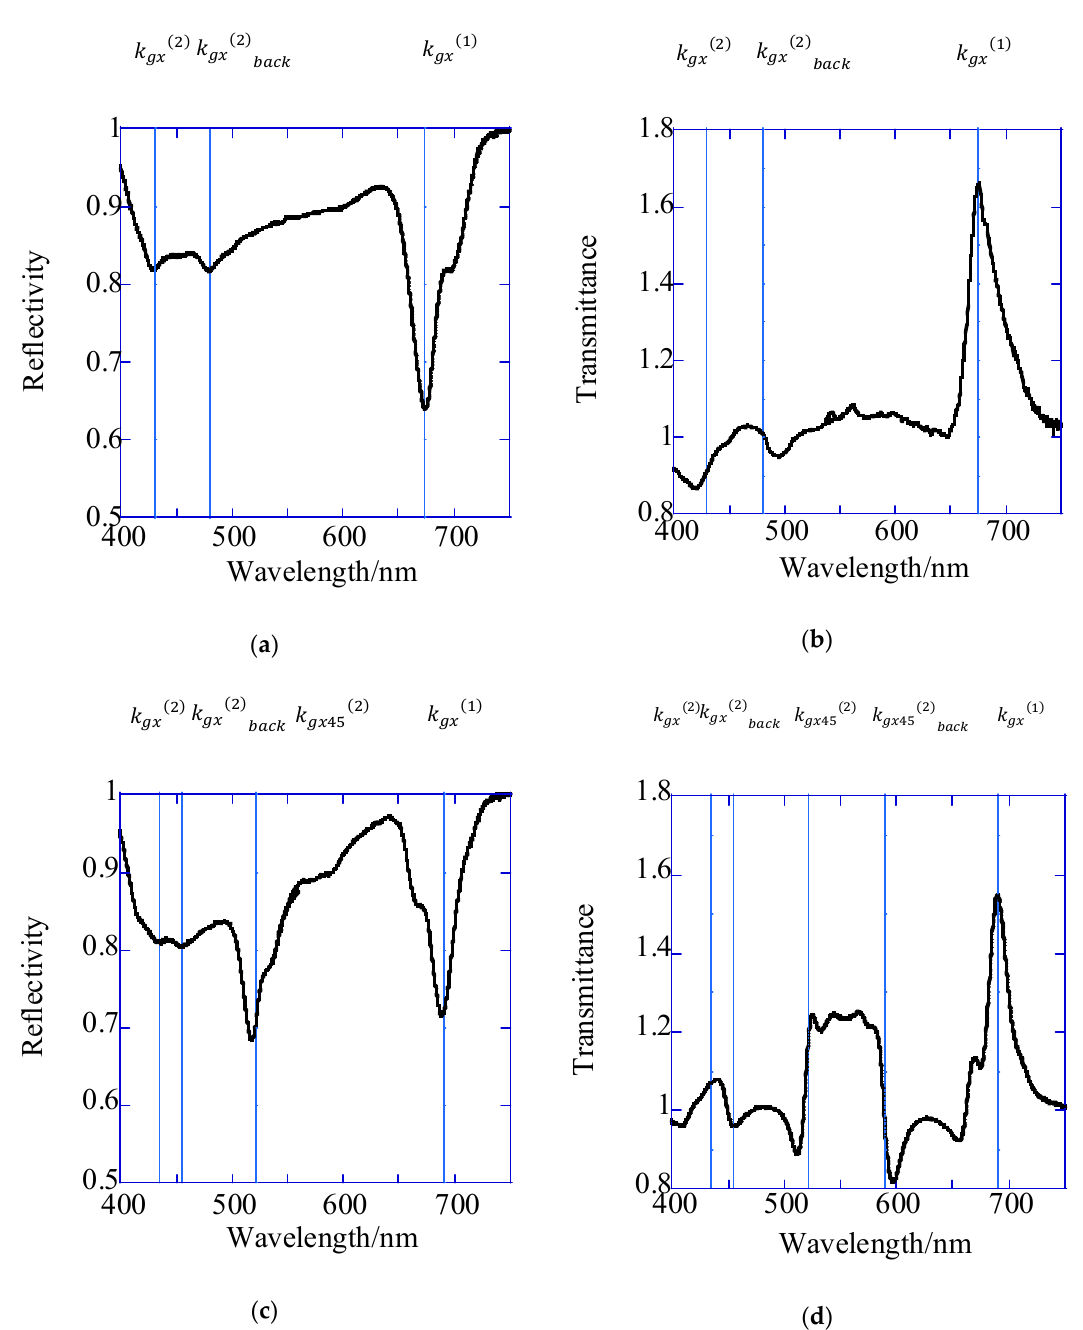
Figure 4. Relative reflection ( a , c ) and relative transmission ( b , d ) spectra for 1D ( a , b ) and 2D ( c , d ) plasmonic chips.